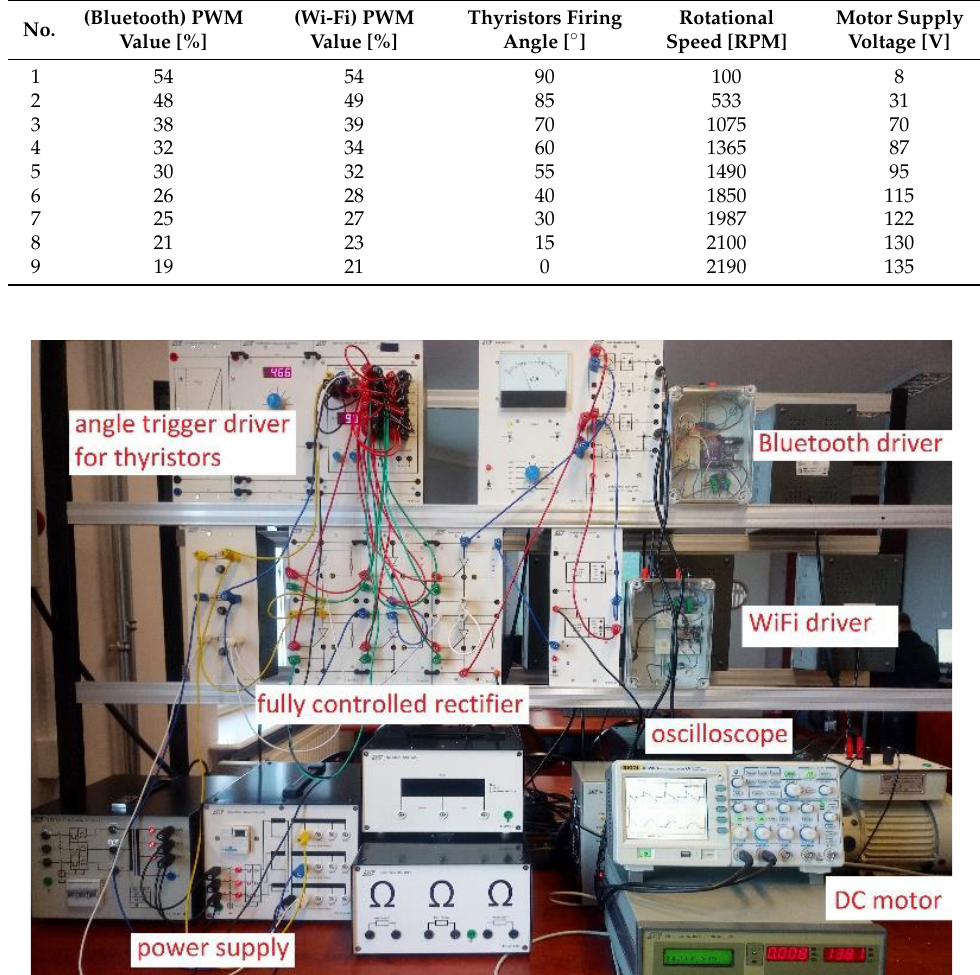
Table 3. Measurements for both control systems with wireless communication.